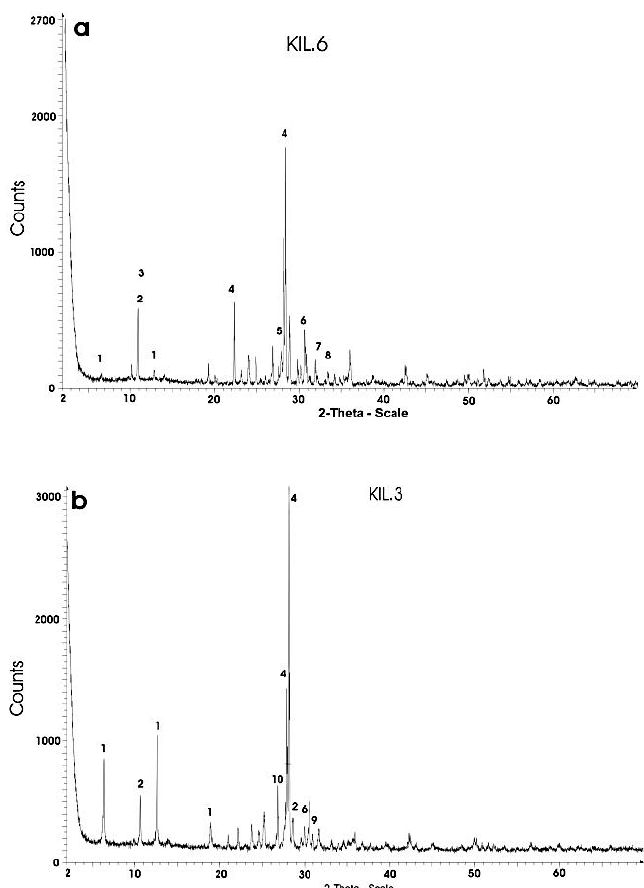
Figure 5. Representative X-ray diffraction patterns of the studied mafic rock samples: ( a ) gabbro and ( b ) diabase. Sample numbers are indicated as insets (1: chlorite, 2: actinolite, 3: hornblende, 4: plagioclase, 5: titanite, 6: orthopyroxene, 7: olivine, 8: apatite, 9: epidote, 10: quartz).